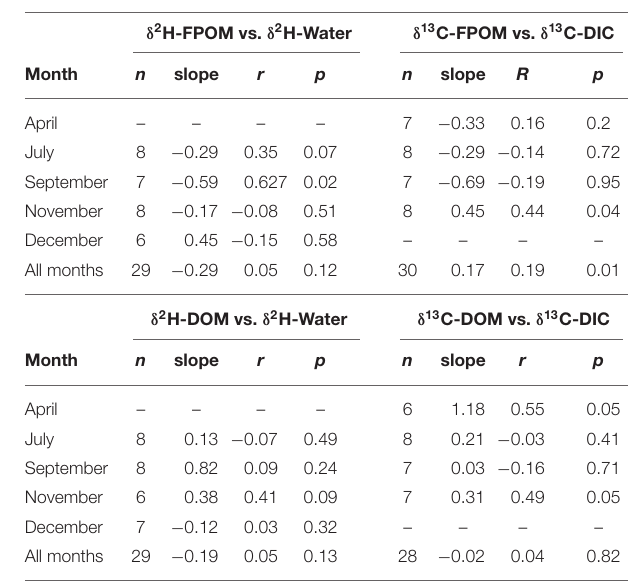
TABLE 3 | Regressions results for graphical analysis of gradient based mixing models of FPOM (top) and DOM